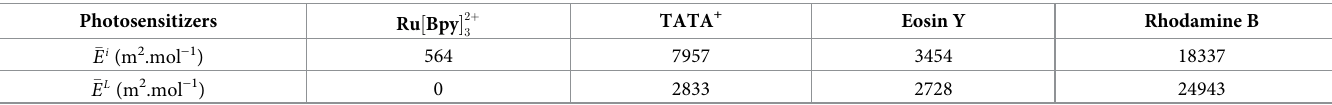
Table 1. The table summarizes mean molar extinction cross-sections for each photosensitizer. � E i is weighted by the incident AM1.5 source in the spectral range [280 nm, 650 nm] for Ru ½ Bpy � 2 þ , Eosin Y and Rhodamine B, and in the spectral range [335 nm, 650 nm] for TATA + due to extinction coefficient data availability (see Eq 5 and 3 Fig 3). � E L is weighted by the luminescence emission spectra (see Eq 7). Note that p L ( λ ) = 0 for l = 2½ l L 550 nm and l L ¼ 775 nm for TATA + , l L ¼ 475 nm and l L ¼ 675 nm for Eosin Y and l L max min max